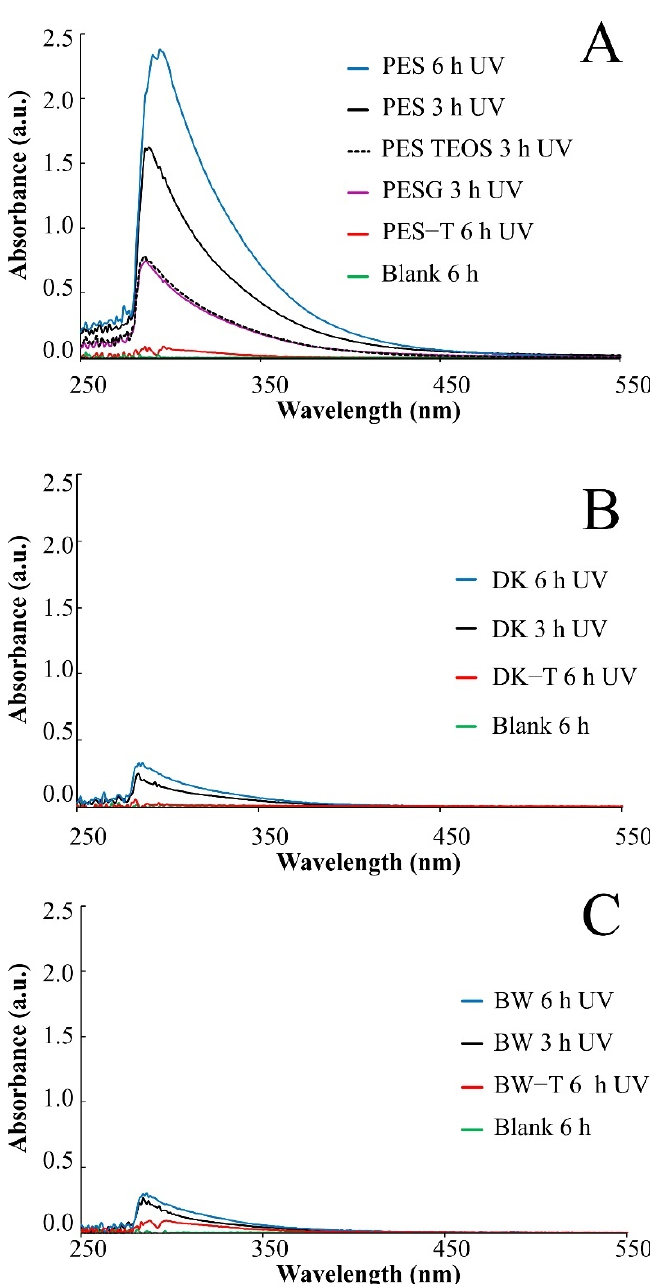
Figure 2. UV-Vis spectra for aqueous samples recovered after UV exposure of the membranes. ( A ) PES: Polyethersulfone (0.2 µm) before and after each coating layer of sol–gel modification (PES-G, PES-TEOS, and PES-T); ( B ) DK and ( C ) BW before and after sol–gel modification with TiO 2 (DK-T and BW-T).